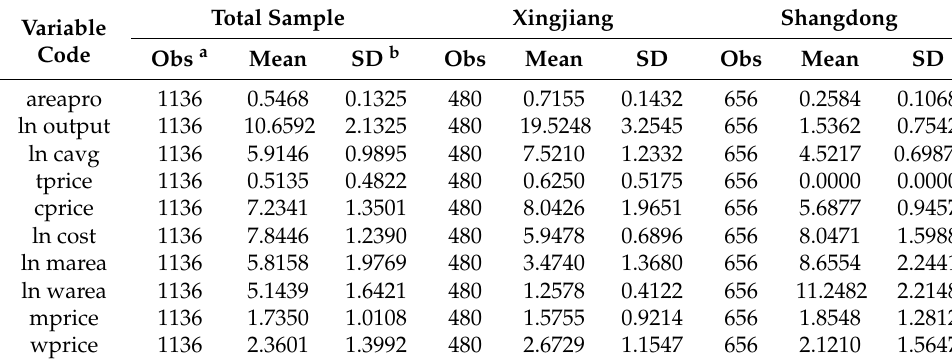
Table 2. Descriptive statistics of the variables in the model.